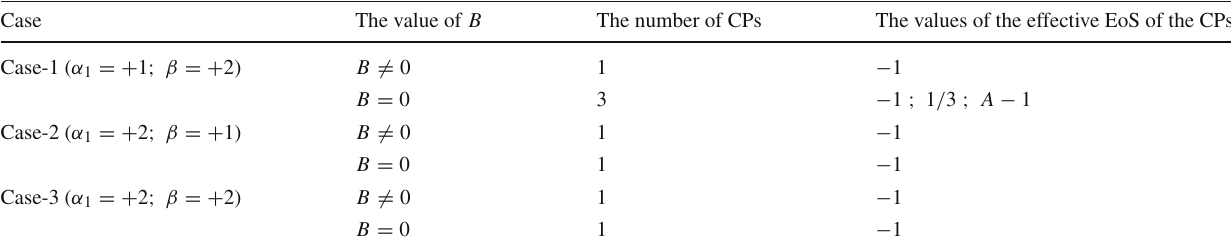
Table 1 A short review of some features of “More Complicated forms of the EoS” Case The value of B The number of CPs The values of the effective EoS of the CPs